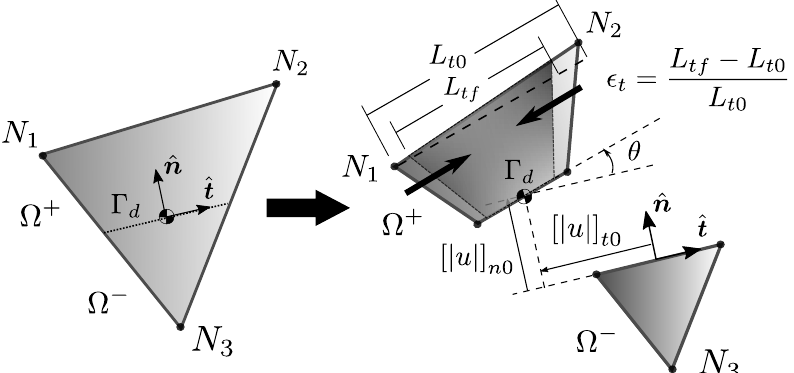
Figure 9. Enriched kinematics variables on the fracture local frame for a 2D CST element having a fracture line Γ d with orientation vectors ˆ n , ˆ t and nodes N 1 , N 2 lying on Ω + . This kinematic variable set is composed of two rigid body translations [ axial strain (cid:101) t on the direction parallel to Γ d . The centroid of Γ d is taken as the zero reference for rigid body motion